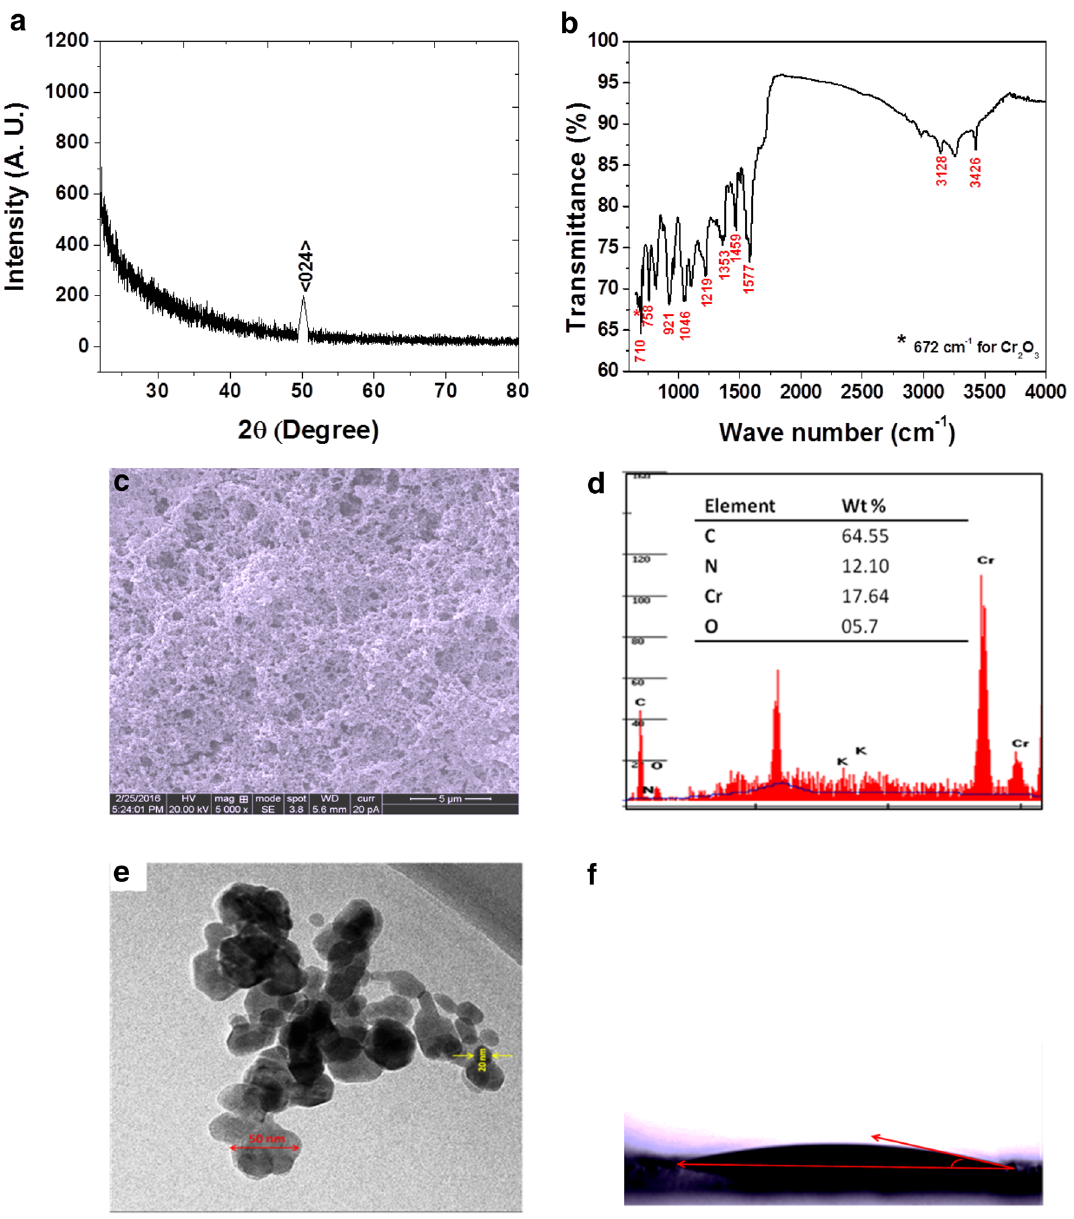
Fig. 2 a XRD pattern, b FTIR spectrum, c SEM image and d EDX spectrum of PPy:Cr surface wettability